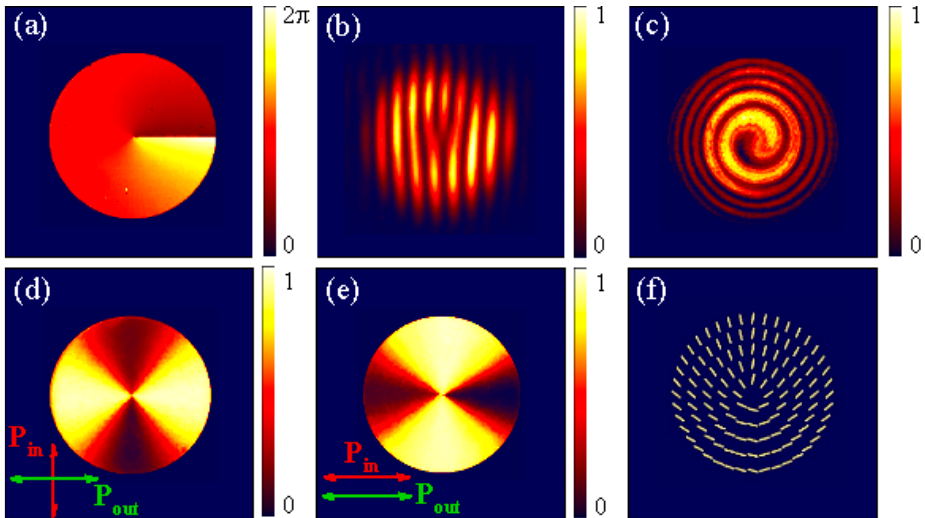
Figure 3. ( a ) Experimentally measured phase retardation of spiral phase structure ( 𝑙 = 1 ). ( b ) and ( c ) are the measured intensity patterns of the generated vortex beam interfering with a plane wave and a spherical wave, respectively. ( d , e ) Polariscopic images of optical axis distribution of the glass vector-vortex plate under crossed polarizers. Pin and Pout stand for the polarization states of the input and output beams, respectively. ( f ) The optical axis distribution of the q plate is retrieved by the polariscopic images.